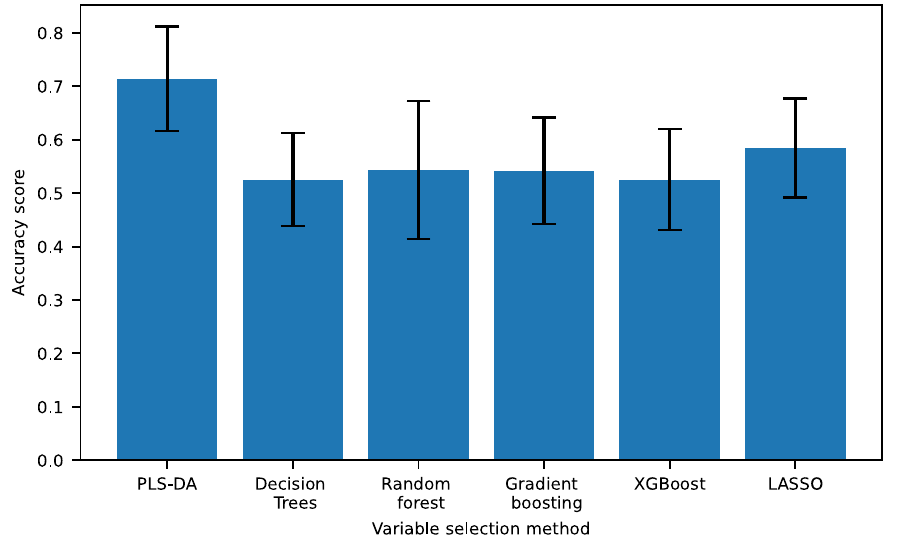
Fig 7. Accuracy scores for the variable selection methods with error bars showing the standard deviation over 25 training/test set splits.